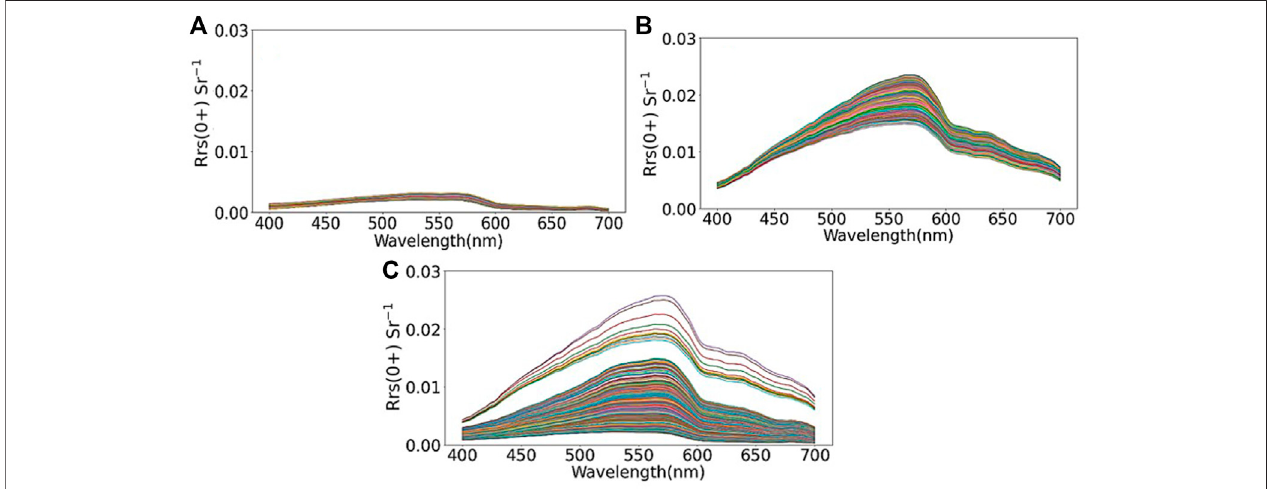
FIGURE9| R rs (0+)spectrameasuredon2September2019for (A) oceanicwaters(Min;Max;SD;Mean=0.0019;0.0029;0.00017;0.0021Sr − 1 (B) plumewaters (0.0131; 0.0186; 0.0013; 0.0165 Sr − 1 , respectively) and (C) estuarine waters (0.0021; 0.0199; 0.0021; 0.0058 Sr − 1 , respectively). The descriptive statistics shown are for Sentinel 3 OLCI Band 5 or 510 nm.